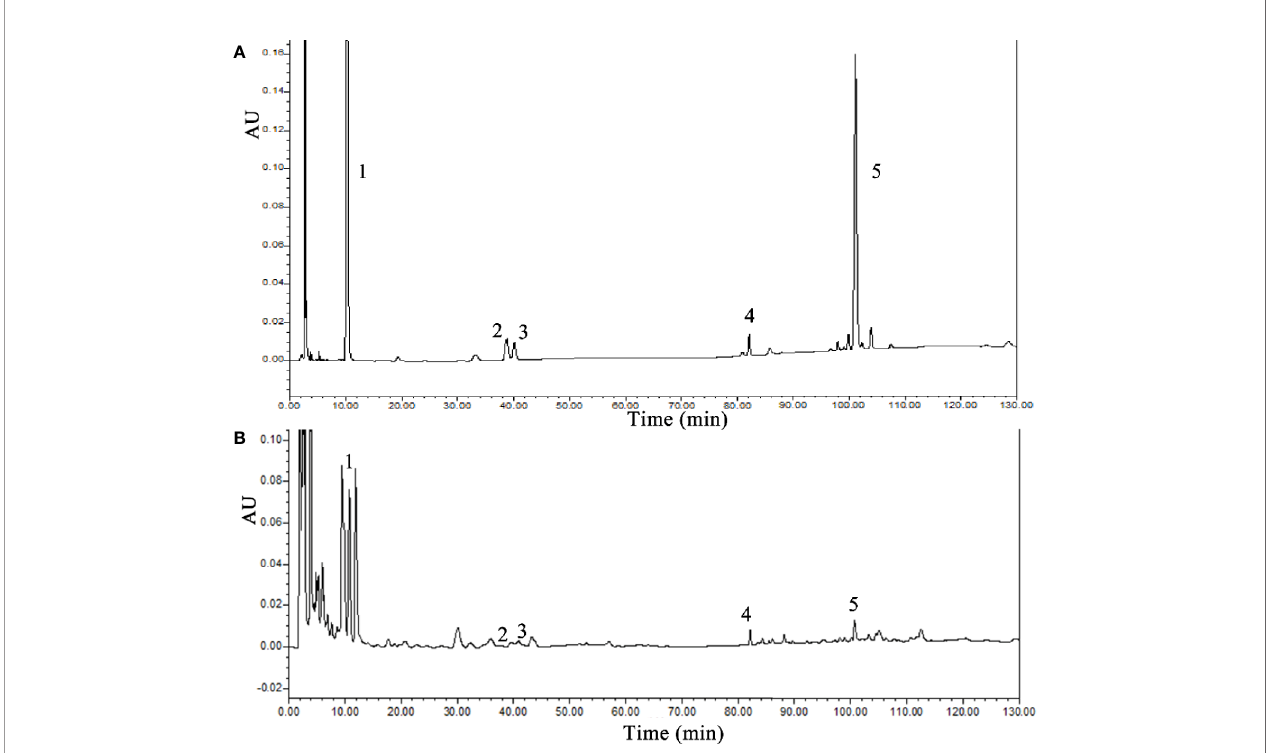
FIGURE 1 | HPLC analysis of SLBZS. (A) SLBZS decoction. (B) Standards: 1, liquiritin; 2, ginsenoside Re; 3, ginsenosideRg1; 4, ginsenosideRb1; 5,